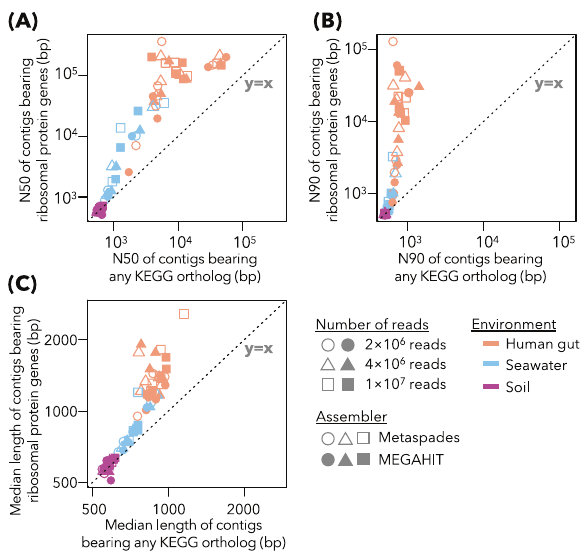
Fig. 3 Distribution of ribosomal protein genes in assembled contigs. The relationship between N50 of all the contigs bearing any KEGG ortholog and N50 of the contigs bearing at least one ribosomal protein ortholog. Each point represents one assembly and is colored according to the source material of metagenome. The dotted line indicates y = x, where two N50 values are equal. B Same as A , although N90 was used instead of N50. C Same as A , although the median length of the contigs was used instead of N50.